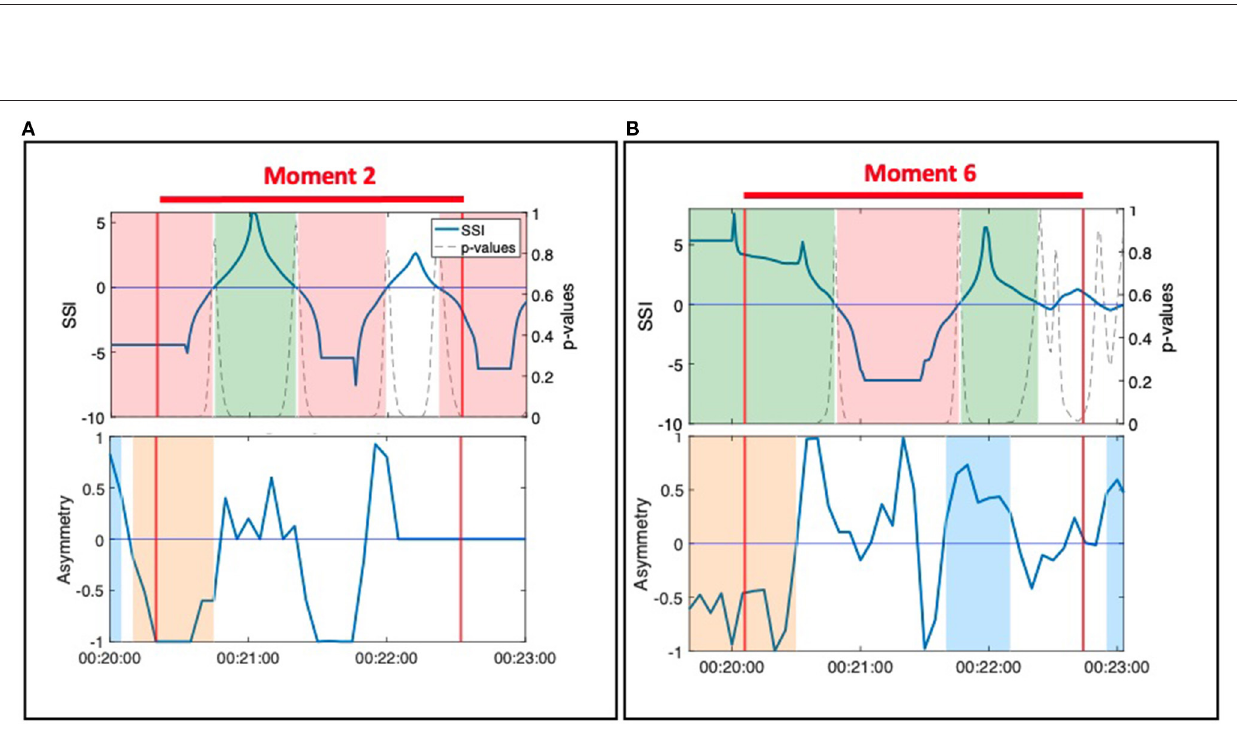
Frontiers in Psychology |